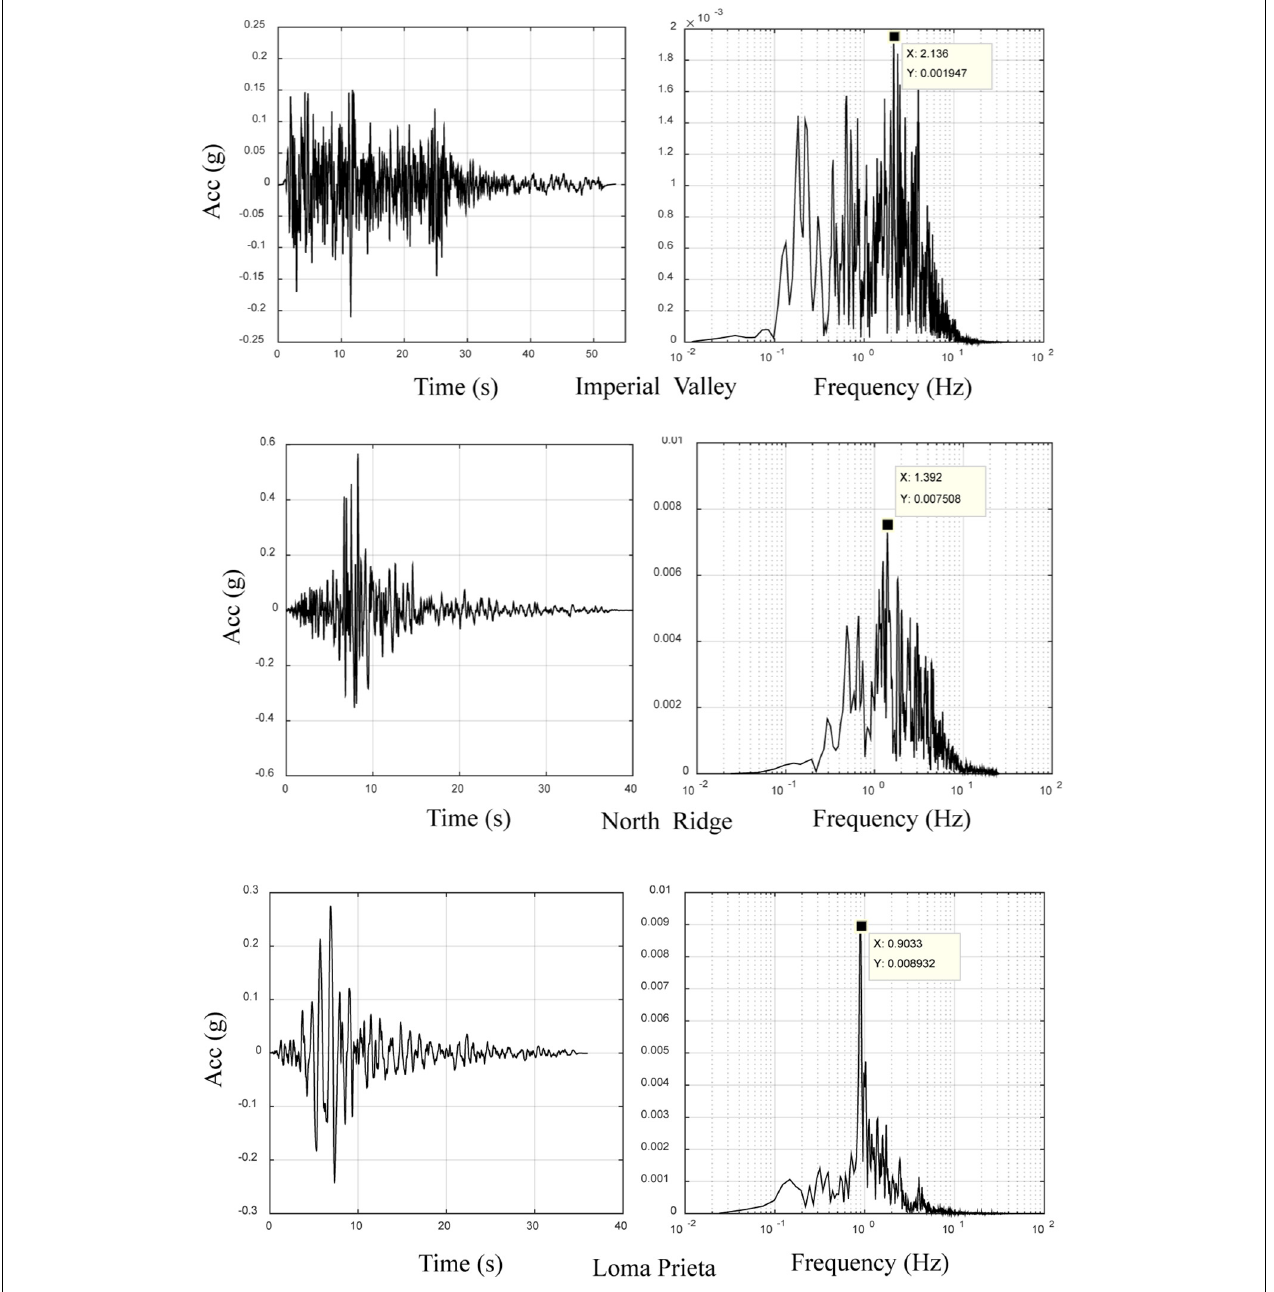
FIGURE 3 | Selected input